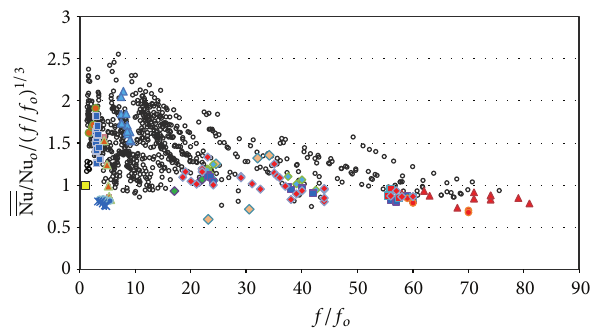
Figure 19: Comparison of relative performance of rib turbulators, pin fins, swirl chambers, dimple-smooth arrangements, dimple- protrusion arrangements, dimple-dimple arrangements, surface roughness, and smooth-walled channels, including results from investigations after 2003. Globally averaged thermal performance parameters Nu / Nu 𝑜 /(𝑓/𝑓 𝑜 ) 1/3 are presented as dependent upon friction factor ratios 𝑓/𝑓 𝑜 . Symbol definitions are given in Figure 18.